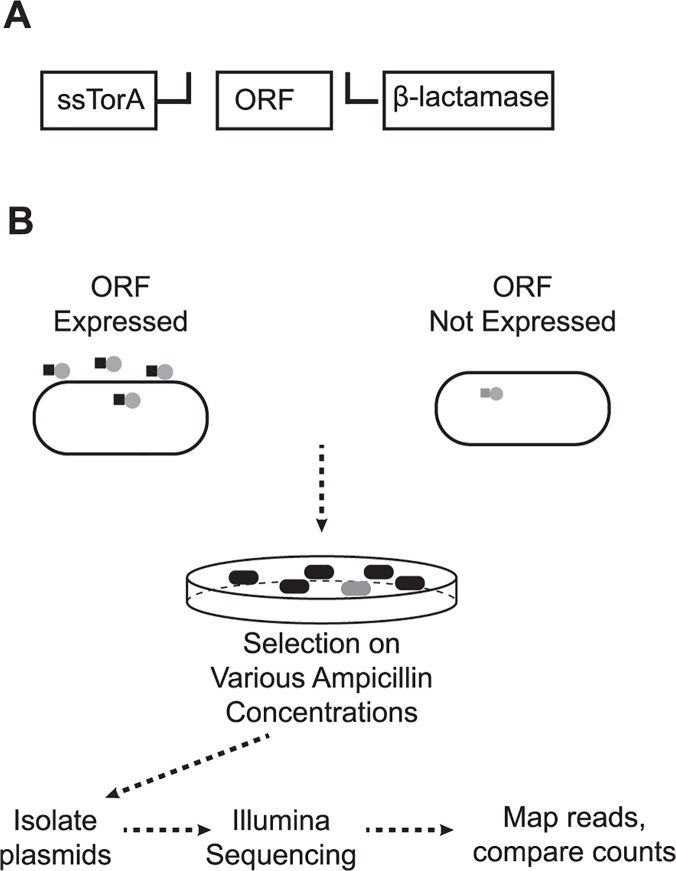
Expression correction for properly folded soluble proteins.(A) The synthesized gene library open reading frames (ORFs) are cloned via RE1/RE2 into a vector containing an N-terminal Tat pathway secretion signal (ssTorA) and a C-terminal TEM-1 β-lactamase. (B) Synthesized genes that are expressed, properly folded, and soluble result in the export of mature β-lactamase fusions to the E. coli periplasm, which confers ampicillin resistance. Selection against insoluble protein serves to both remove correct gene sequences which are poorly expressed in E. coli and remove incorrect gene synthesis products as the resulting protein is often insoluble. Expression profiling is characterized with Illumina MiSeq next generation sequencing.